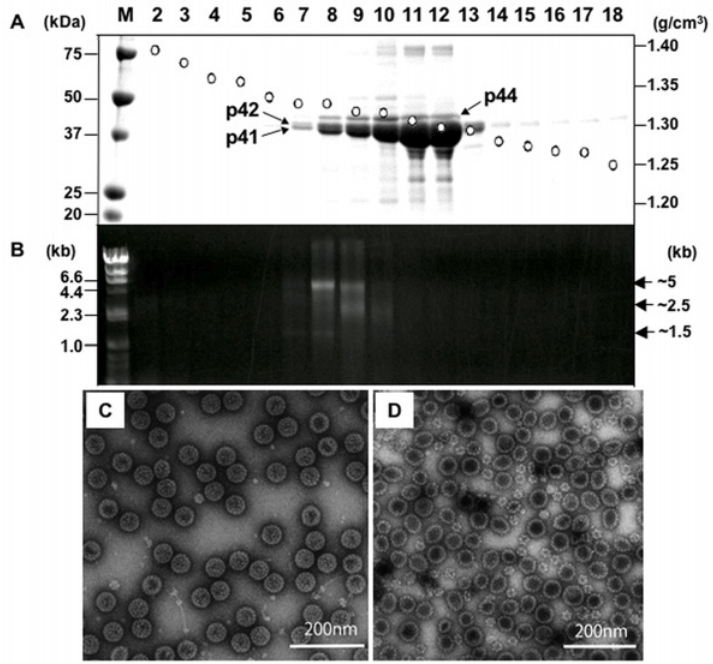
Fig 2. Purification and structural characterization of MCV-LP. The supernatant of AcMCPyV-VP1- infected cells was centrifuged for 3 h at 32,000 rpm in a Beckman SW32Ti rotor. The pellet was then re- suspended in 500 μ l medium, and then purified by CsCl equilibrium density gradient centrifugation. Aliquots from each fraction were analyzed by SDS-PAGE and stained with Coomassie blue (A). Nucleic acids extracted from each fraction were analyzed by agarose gel electrophoresis (B). Fractions 7 – 9 (C) and 11 – 13 (D) were pooled, respectively, followed by staining with 2% uranyl acetate and observation by EM. Bars, 200